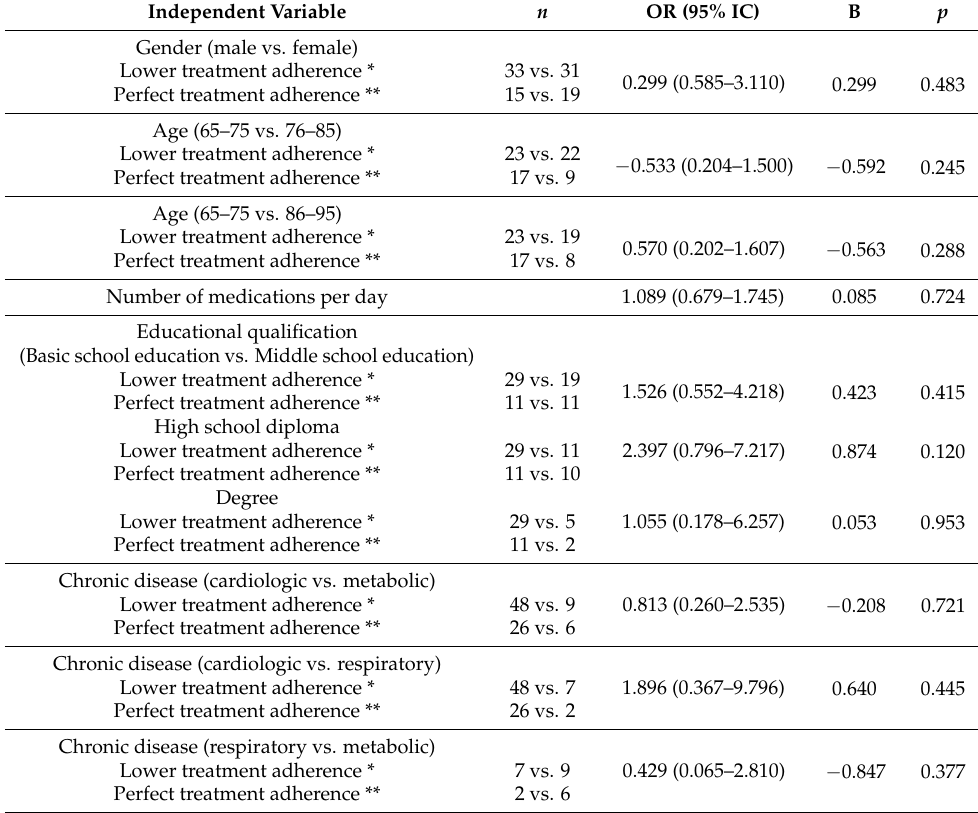
Table 6. Incidences of patients’ characteristics on reported